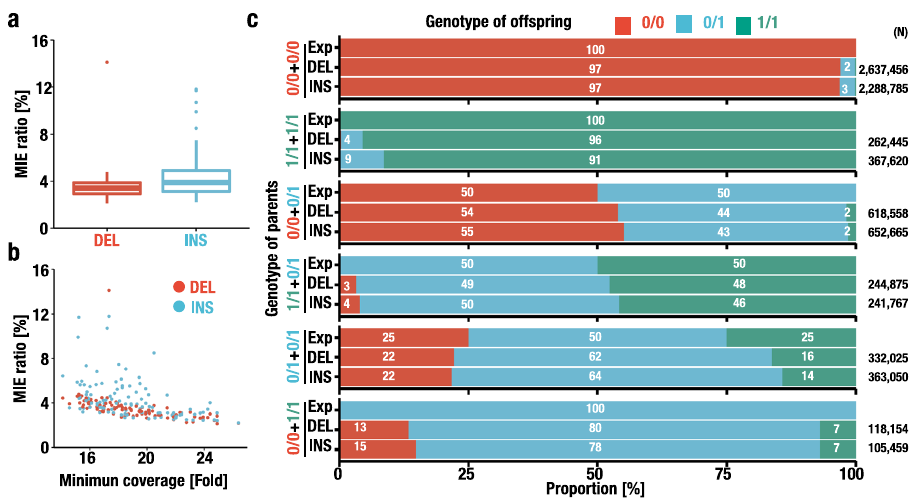
Fig. 4 Quality assessment of the SV dataset based on Mendelian inheritance. a Mendelian inheritance error (MIE) ratio per trio. The MIE ratio was calculated for each trio. Each boxplot has a box that represents the interquartile range (IQR) and whiskers that extend 1.5 × IQR from the box edges. The median is shown in a horizontal line in the box. Outliers are shown in dots. n = 111 for both DEL and INS. b Scatterplot showing the relationship between the sequencing coverage and the MIE ratio. The minimum coverages among three individuals who belong to a trio and the MIE ratio observed in the trio are plotted on the x - and y- axes, respectively. n = 111 for both DEL and INS. c Distribution of genotype calls in parent – offspring trios. 0 and 1 denote the reference and alternative alleles, respectively. Genotypes of the parents are shown on the y axis, and the frequencies of each genotype (0/0, 0/1, and 1/1; red, blue, and green, respectively) that were expected (Exp) and observed in DELs (DEL) and INSs (INS) are shown. The number of pairs tested are shown on the